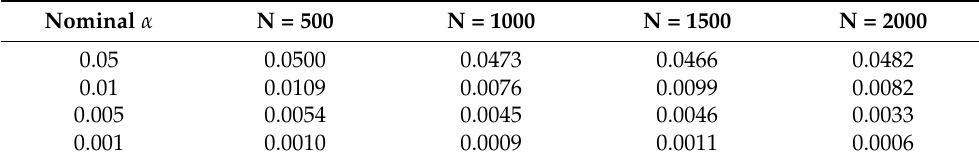
Figure 2. Power simulation for binary outcomes based on random LD blocks, two reverse-sign causal loci. Table 1. Type I error simulation using cGFLM for binary outcomes based on randomly generated LD